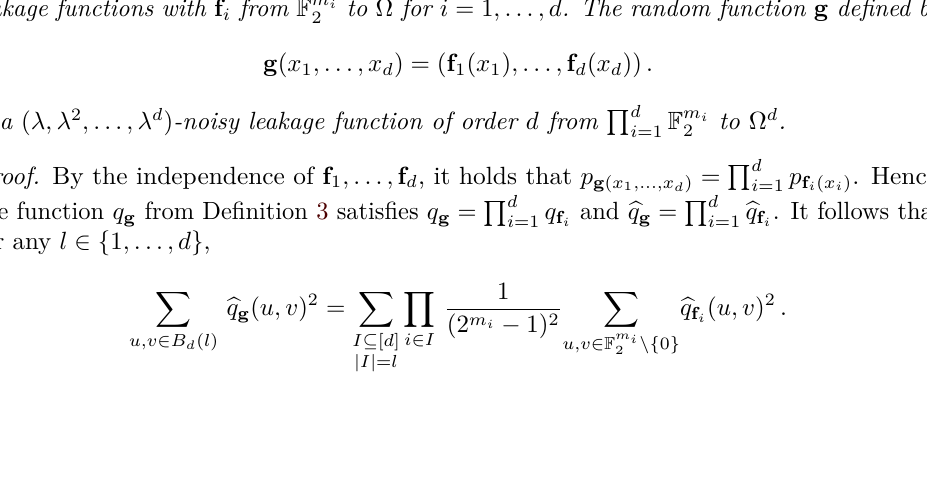
Noise Amplification The real-world value of the probing model relies in large part